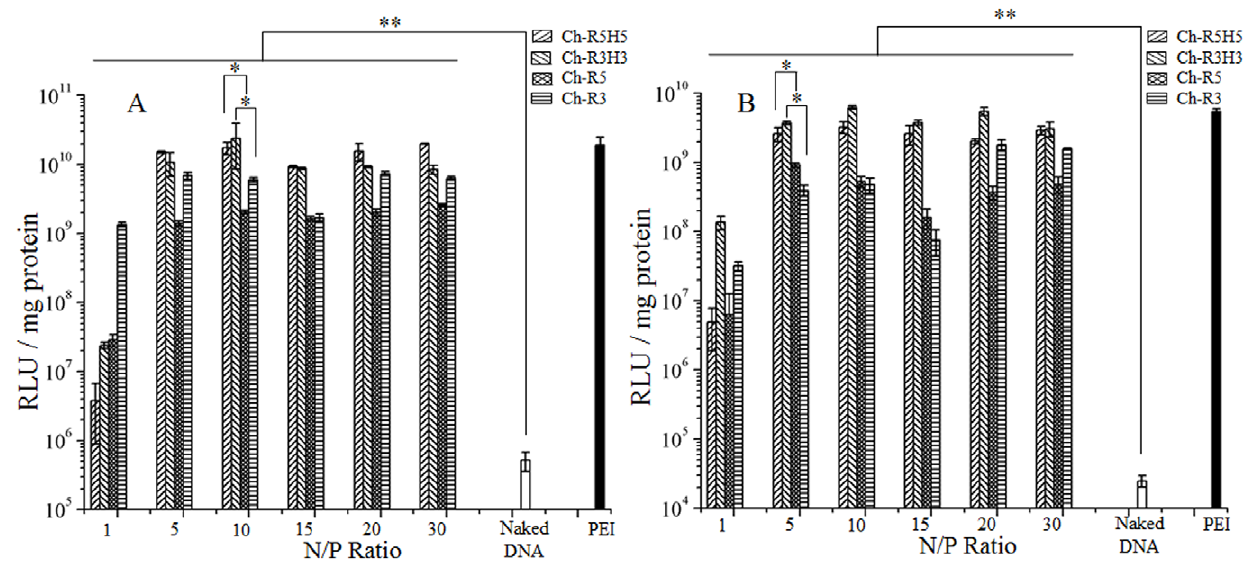
Figure 4. Luciferase expression levels induced by Ch-R5H5/DNA, Ch-R3H3/DNA, Ch-R5, and Ch-R3 complexes in mammalian cells. DNA and PEI/DNA complex at an N/P ratio of 10 are used as negative and positive controls respectively. Error bars represent standard deviation of 4 replicates. Panel A. HEK-293 cell line. Panel B. MCF-7 cell line.